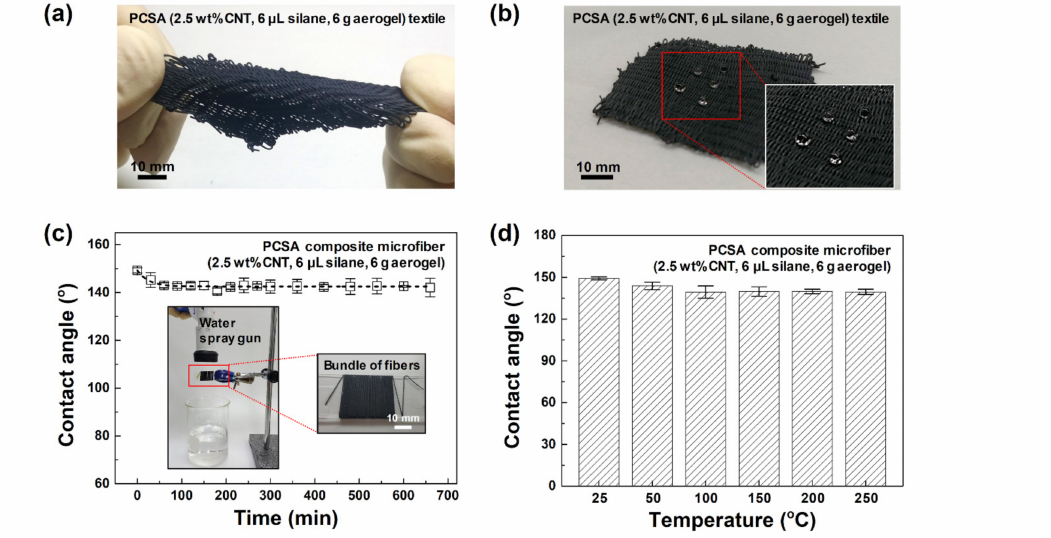
Figure5. ( a )DemonstrationofelasticitywhenstressisappliedtotextilewovenfromthePCSAcomposite microfiber (2.5 wt% CNT, 6 µ L silane, 6 g aerogel). ( b ) Photograph of the textile when exposed to drops of water. WCA of PCSA composite microfibers after ( c ) water spray and ( d ) heating